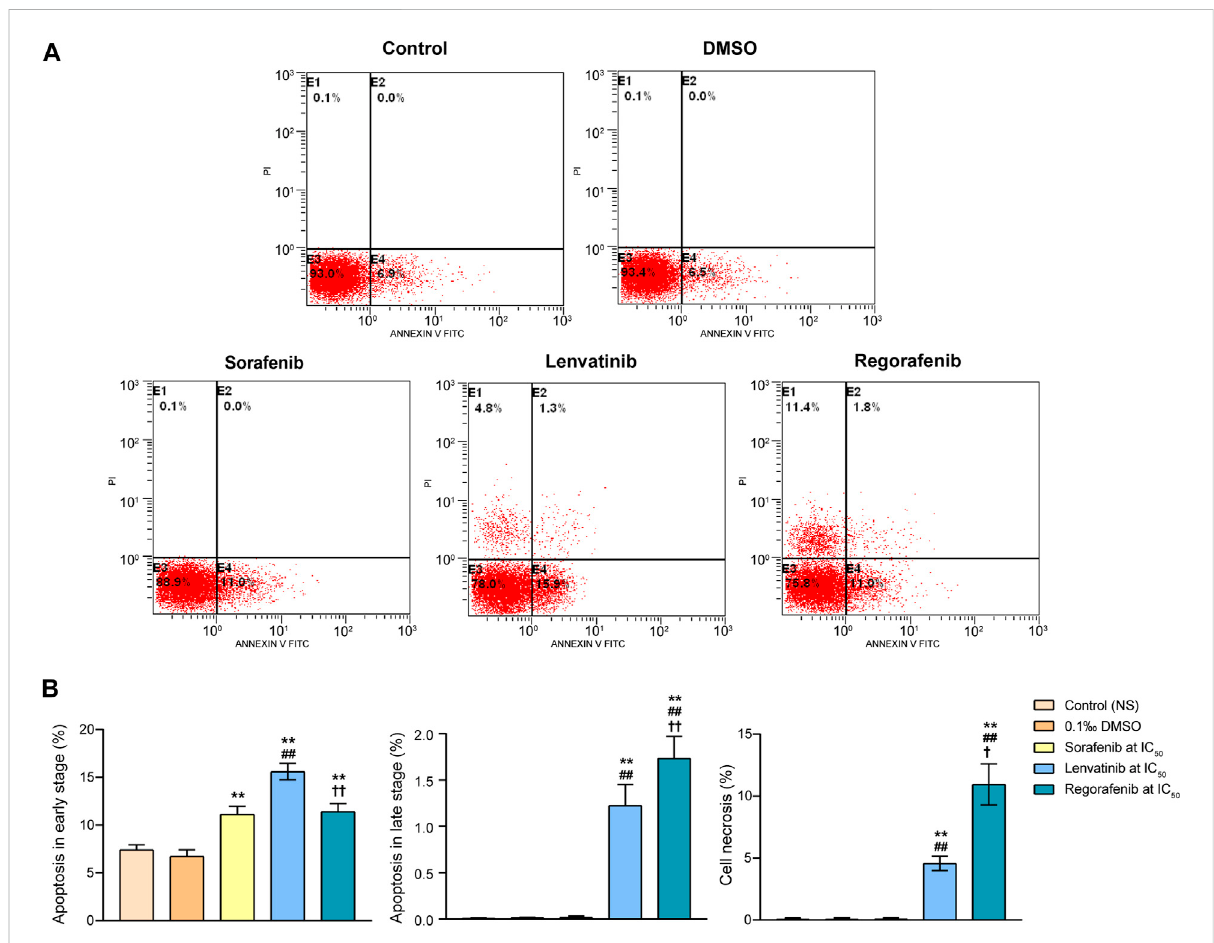
FIGURE 3 Effects of 72 h incubation with respective sorafenib, lenvatinib and regorafenib at their IC 50 on cell apoptosis in Huh-7 cells (A) Representative histograms from sorting of Annexin V/propidium iodide double-stained cells by fl ow cytometry. Cells in quadrants of E1, E2, E3 and E4 present necrotic, late apoptotic, viable and early apoptotic populations, respectively (B) Bar graphs showing the percentage of cells in early apoptotic, late apoptoticandnecroticpopulations.Eachbarpresentsmean±SD( n =3).The** p < 0.01versusDMSO; ## p < 0.01versussorafenib; † p <